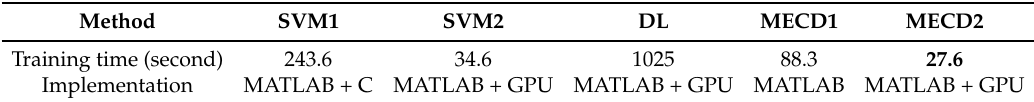
Table 2. Training time and software environment of the crack damage detecting